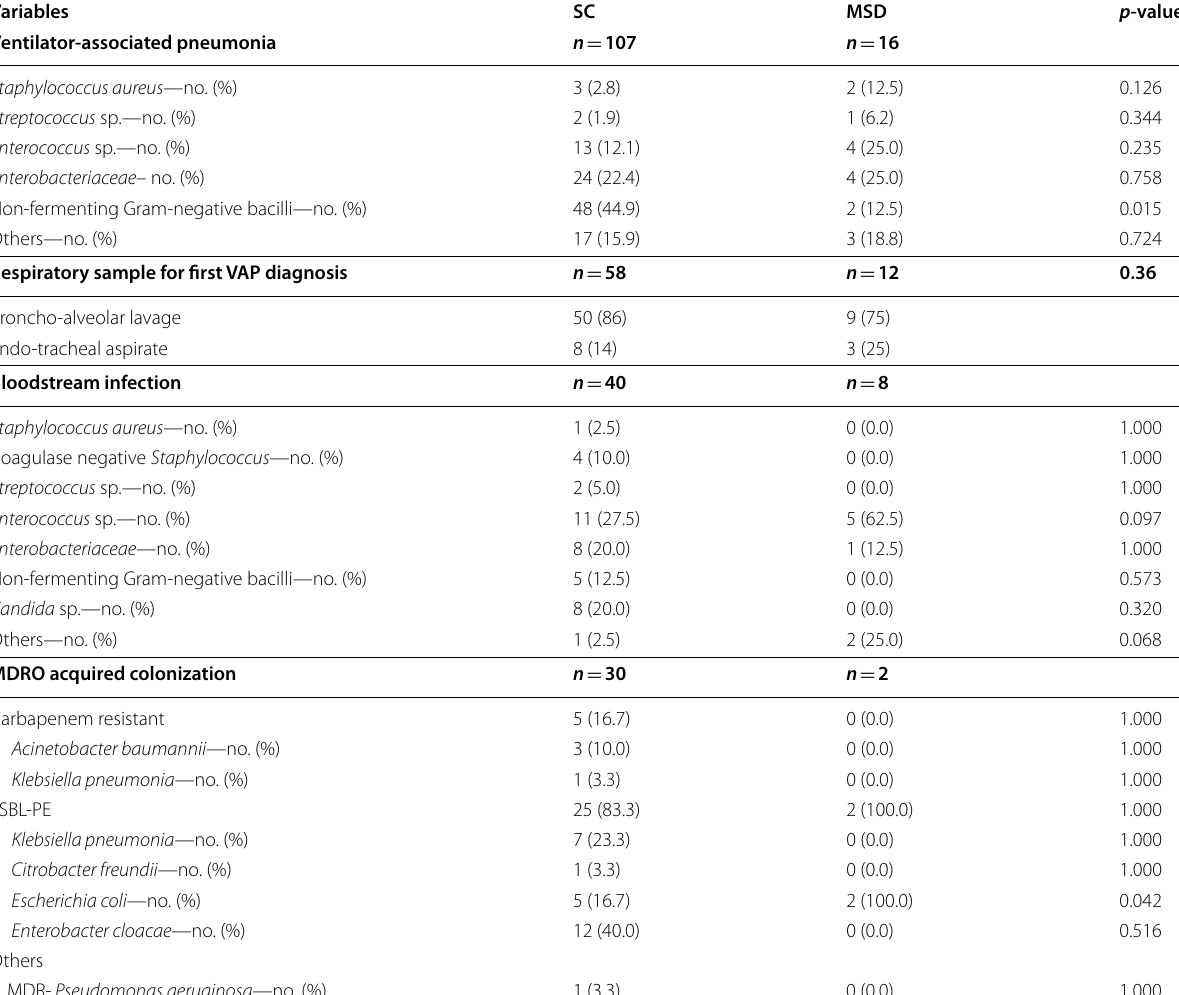
Table 4 Microorganisms responsible for infections and MDRO acquired